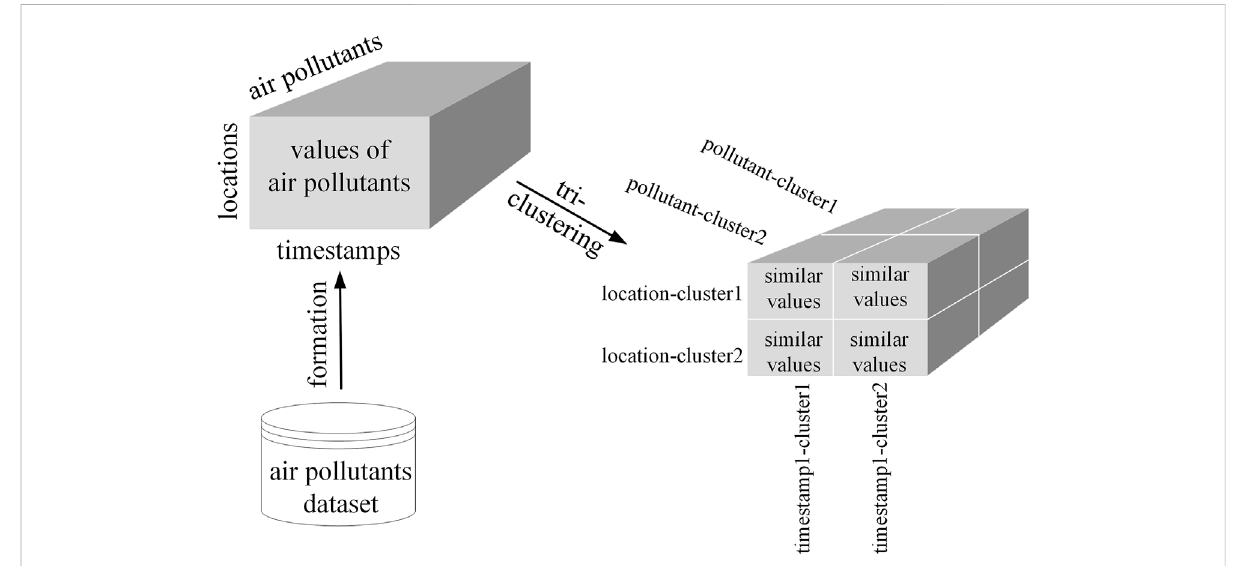
FIGURE 1 Tri-clustering analysis of air